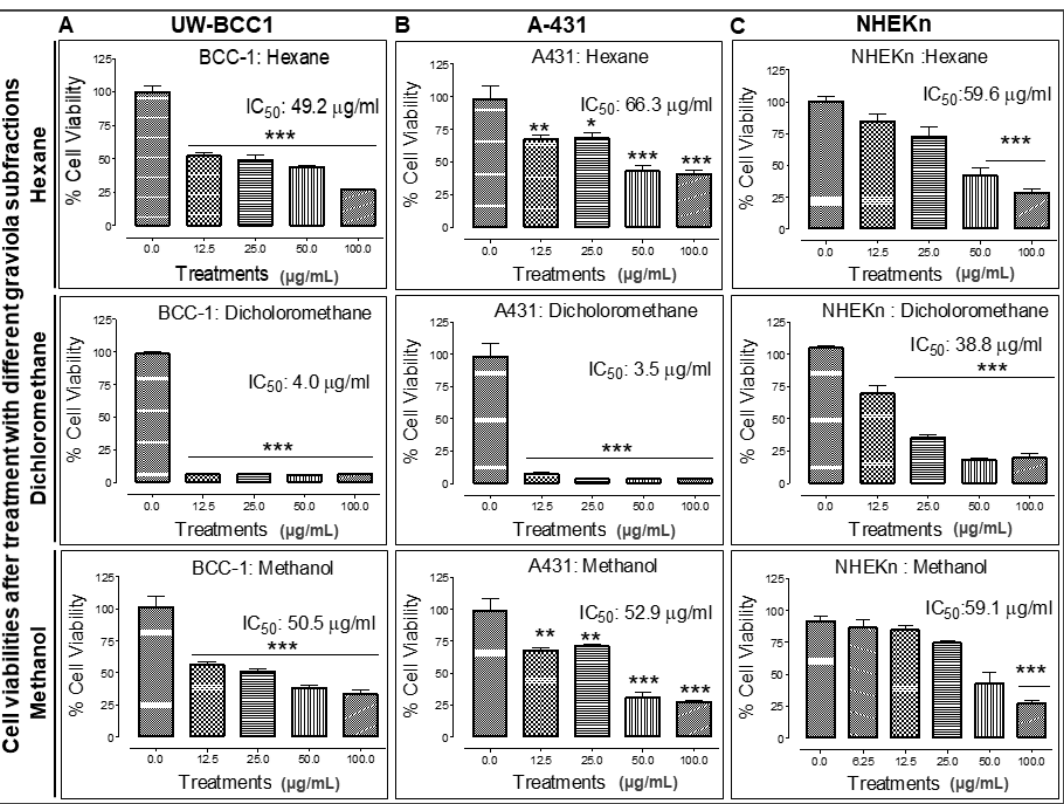
Figure 5. Different solvent-extracted fractions of graviola stem and leaf powder extract display differential inhibition of cell viability in non-melanoma skin cancer (NMSC) cells. UW-BCC1 and A431 as well as control NHEKn cells were treated with one of three fractions of graviola ( n -hexane, dichloromethane, or methanol) for 48 h, and cell viability was determined by MTT assay. Bar graphs show the effect (Mean ± SD) of each fraction on the % viability after each treatment, with IC 50 values in ( A ) UW-BCC1, ( B ) A431 and ( C ) NHEKn cells, at 48 h, shown above the bars. All experiments were performed in triplicate. Details are described in Methods. The p values vs. control (DMSO-treated) cells: * p < 0.05 and ** p < 0.01 and *** p < 0.001.